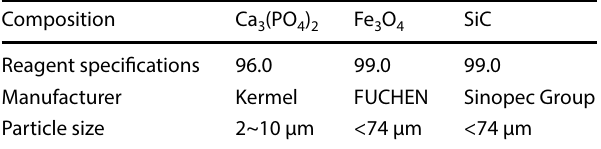
Table 2 FactSage7.1 parameter Settings